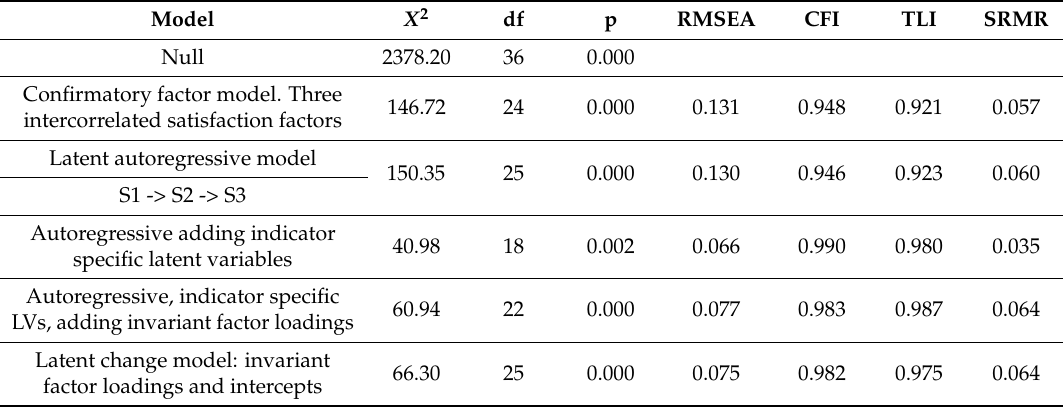
Table 2. Latent state analysis of